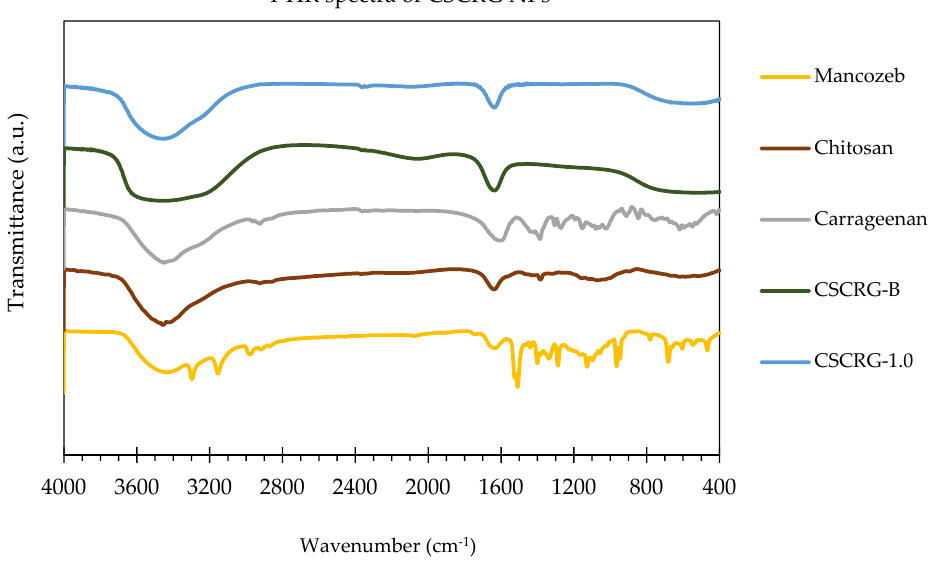
Figure 3. Composite FTIR spectra of mancozeb, blank and loaded CSCRG NPs along with raw pol- ymers.